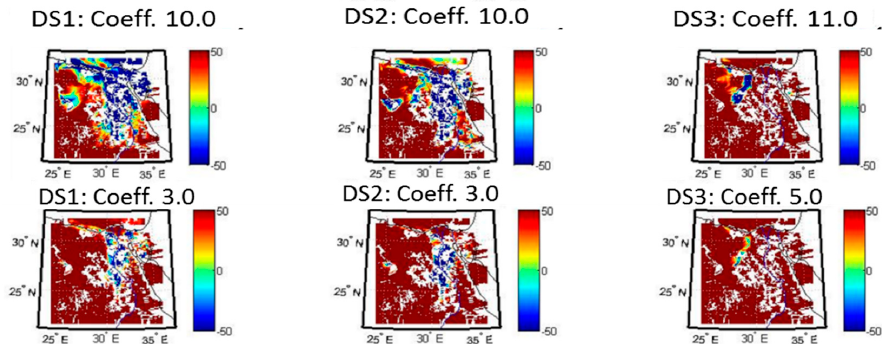
Figure 12. The distribution of spatial error in (%) between MODIS (as reference) Model AOD using selected emission scheme and tuning coefficient for the event of March 2013.